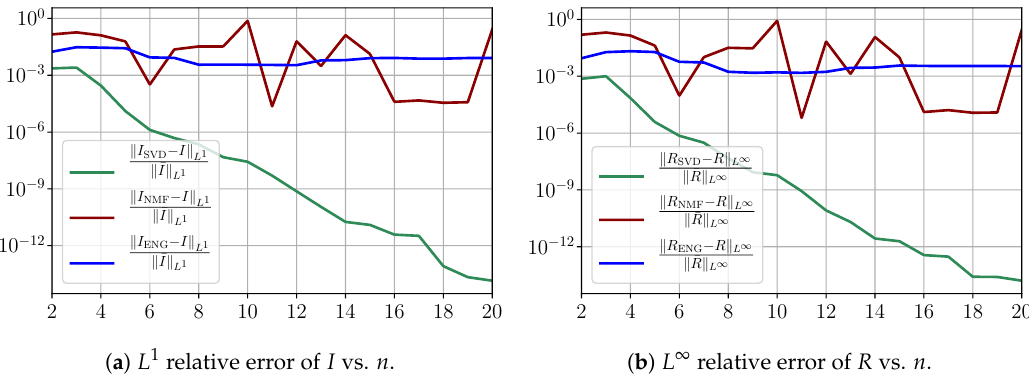
Figure A3. Study of sampling errors: Errors on I and R obtained by the susceptible–infected–removed (SIR) model using the fitted β and γ .